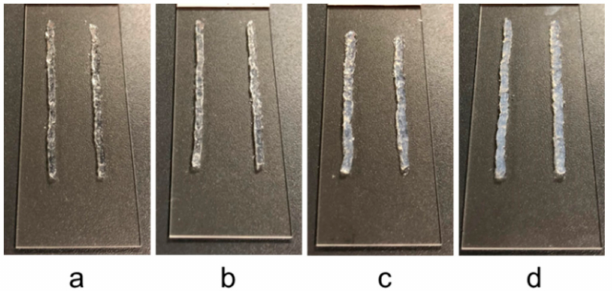
Figure 9. Extruded gels formed by compounds 11 ( a , b ) and 13 ( c , d ) in DMSO/H 2 O (1:1). The concentrations of the gels are 5.0 mg/mL for ( a , c ); 10.0 mg/mL for ( b , d ).